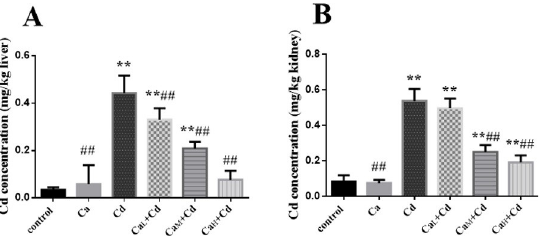
Fig 7. The Cd concentrations in liver(A) and kidney(B). The data are shown as mean ± SD. � P < 0.05, compared with control-group. �� P < 0.01, compared with control-group. # P < 0.05, compared with Cd-group. ## P < 0.01, compared with